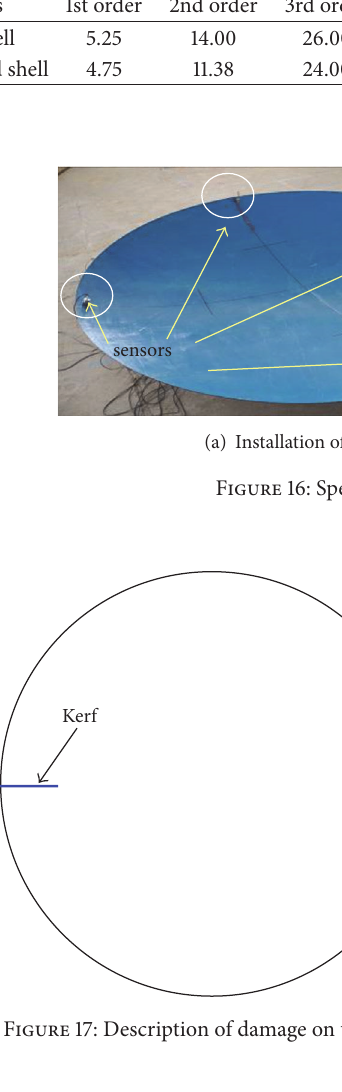
instruments, which were the same as the above tests.